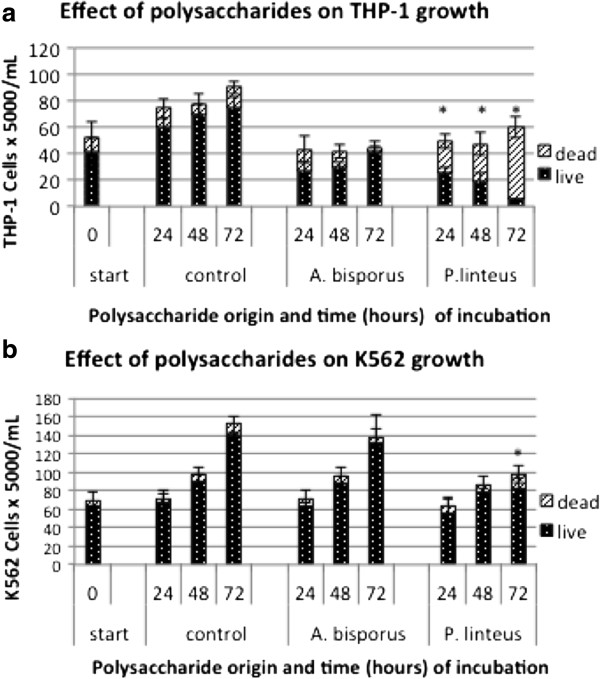
Effect of A. bisporus polysaccharide extract and of P. linteus polysaccharide extract on the growth of THP-1 (a) and K562 cells (b). Samples were taken at 24, 48 and 72 h after the start of incubation; counting was performed using trypan blue and non-colored cells were considered "live". Blue cells were considered "dead". A minimum of 500 cells cells was counted per point. *P < 0.01, significantly different from the values of the control group.